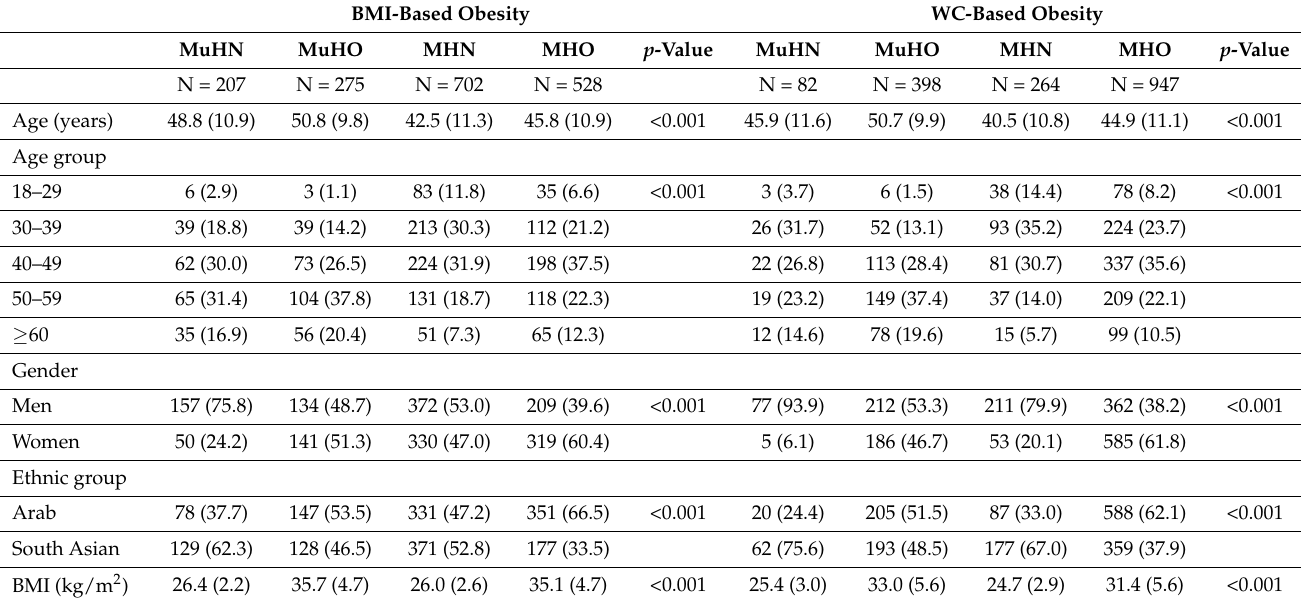
Table 2. Sample characteristics for the BMI- and WC-defined metabolically healthy and unhealthy obese